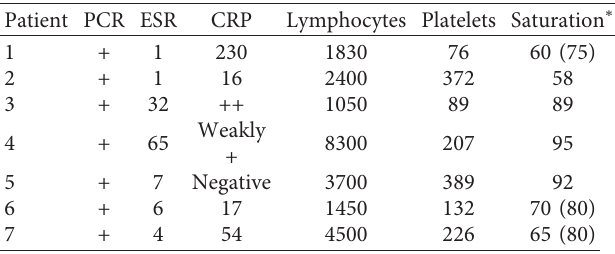
Table 2: Laboratory data of the patients at